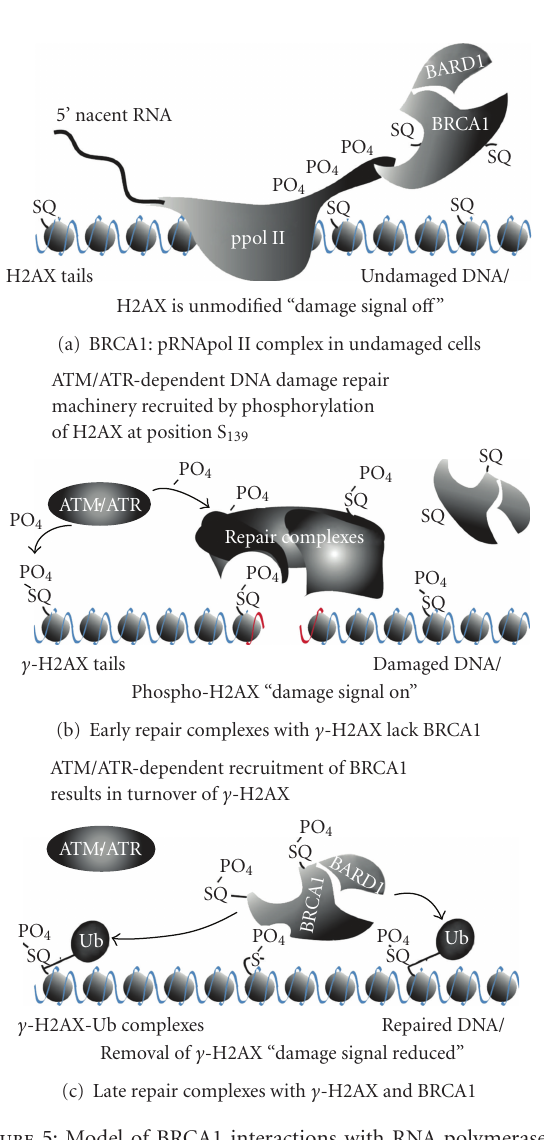
Figure 5: Model of BRCA1 interactions with RNA polymerase II and γ -H2AX in distinct biochemical complexes. See text for